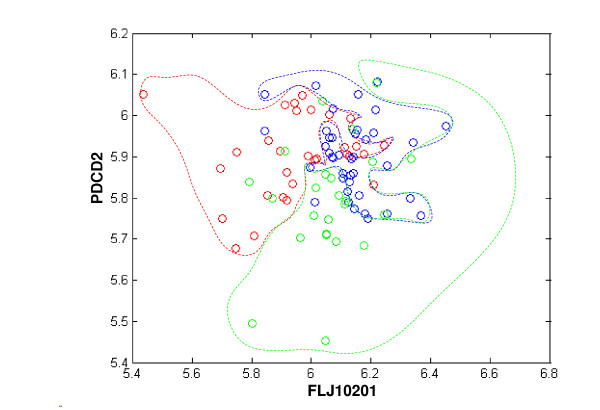
The three classification regions (relapse in 500 days – blue, relapse in 500–1264 days – green, relapse in more than 1264 days – red) as function of the gene expression of the two most predictive genes of the FLP, FLJ10201 and PDCD2. Each point denotes a patient.